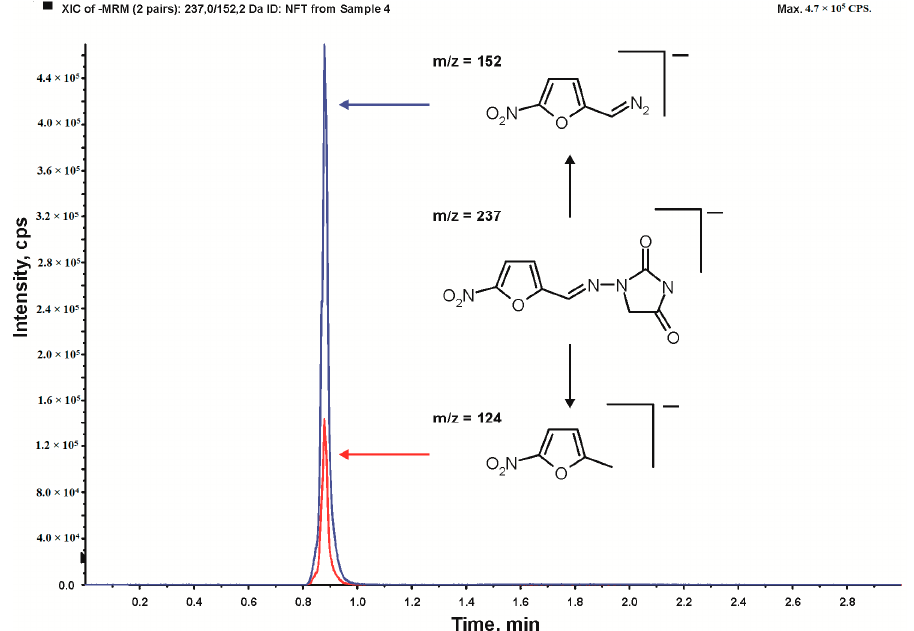
Figure 3. A typical nitrofurantoin chromatogram with two fragmentation transitions used in the multiple reaction monitoring mode.